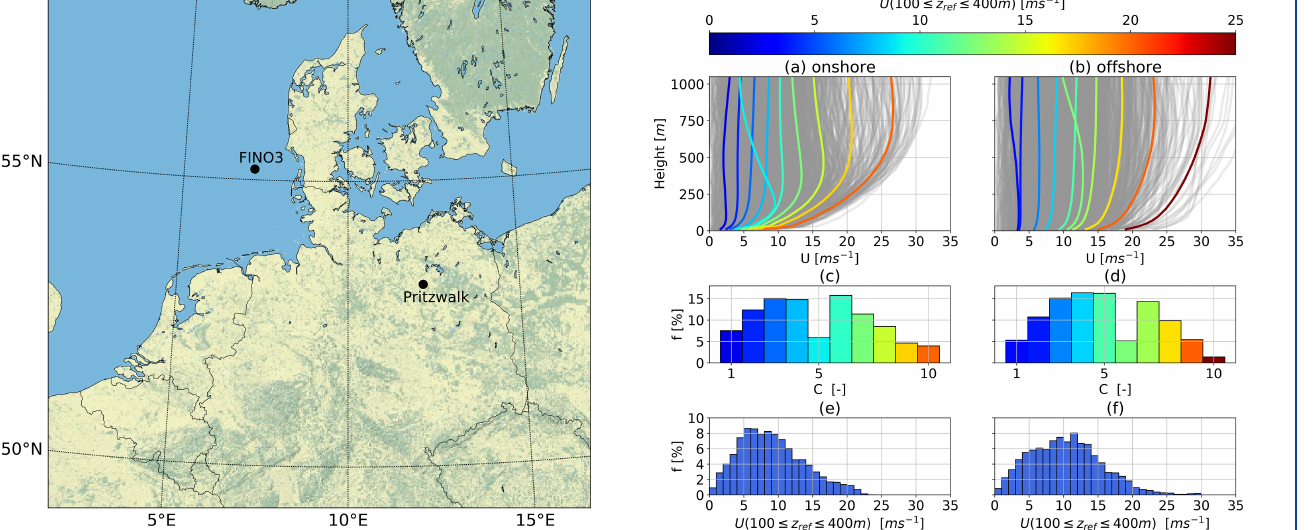
Figure 2. k -means clustered ( k = 10) onshore (a, c, e) and off- shore (b, d, f) annual cluster average wind speed profile cen- troids (a) and (b) . The range of WRF-simulated wind speed profiles is depicted in gray. The centroids are sorted, labeled and color coded according to average wind speed up to 500m. The corresponding cluster frequency f for each cluster C is shown in (c) and (d) . The histograms in (e) and (f) show the wind speed probability distribu- tion at a reference height of 100 ≤ z ≤